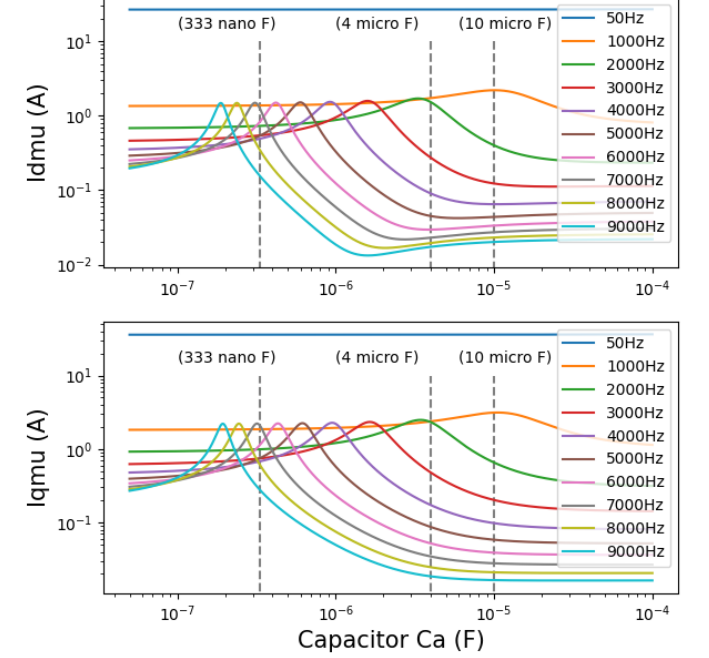
Figure 7. Magnetizing currents versus capacitor values under different frequencies estimated by analytical method. Magnetizing currents in the d-axis ( I h q-axis ( I h q µ ( C a ) , bottom